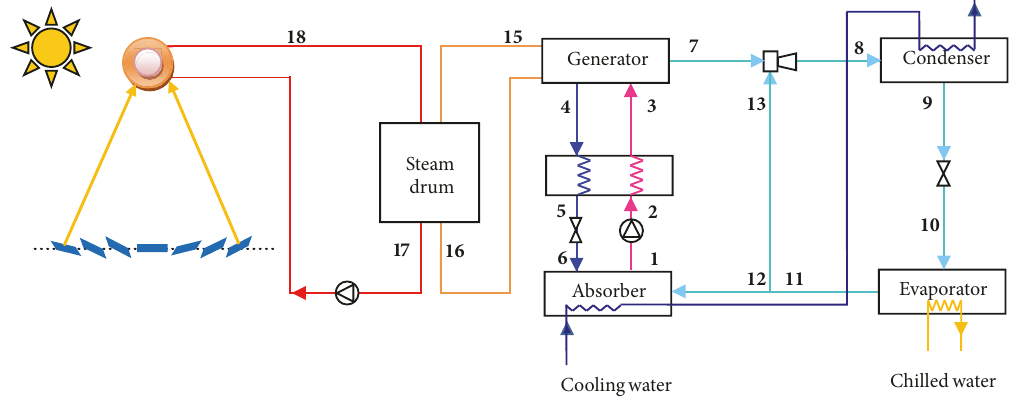
Figure 1: Solar combined ejector single-effect